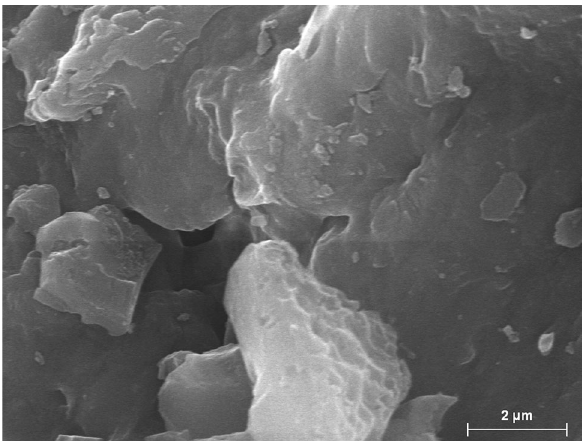
Fig. 4 SEM of C-ZMN